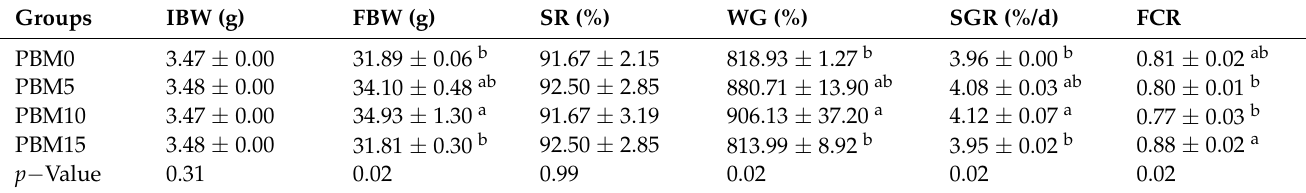
Table 1. Effect of dietary replacement of fish meal with poultry by-product meal on the growth performance of Chinese soft-shelled turtle.